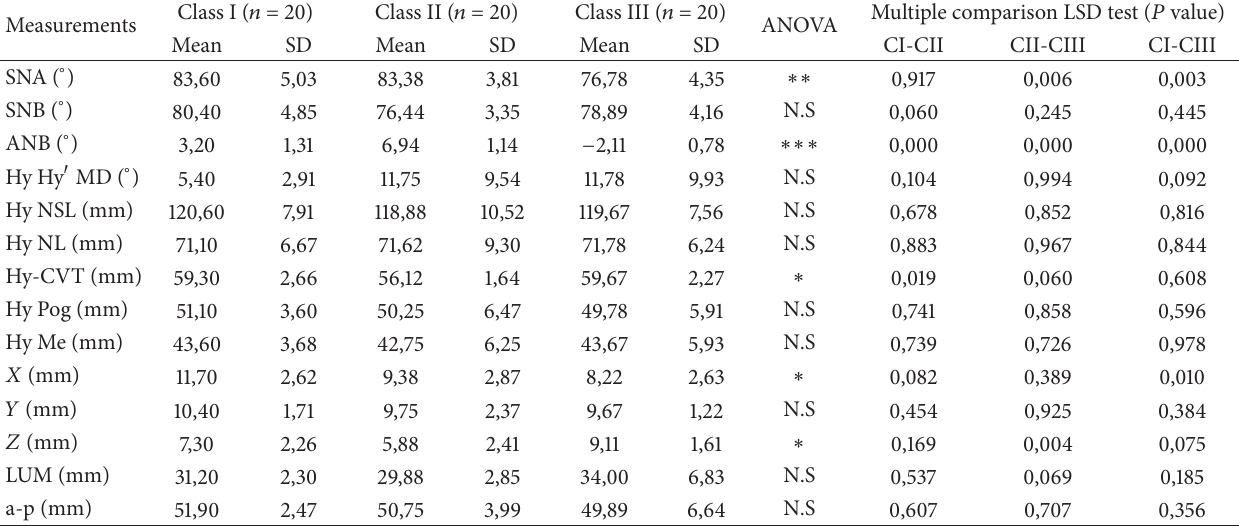
Table 5: Intergroup comparison of mean differences among males with Class I, II, and III skeletal patterns. Measurements